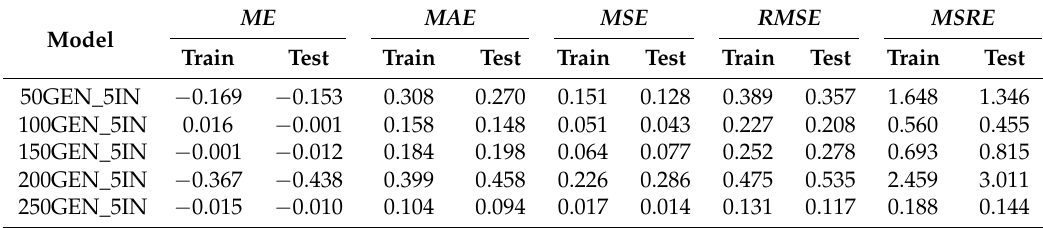
Table 5. Statistical results of ICA ‐ ANN errors.